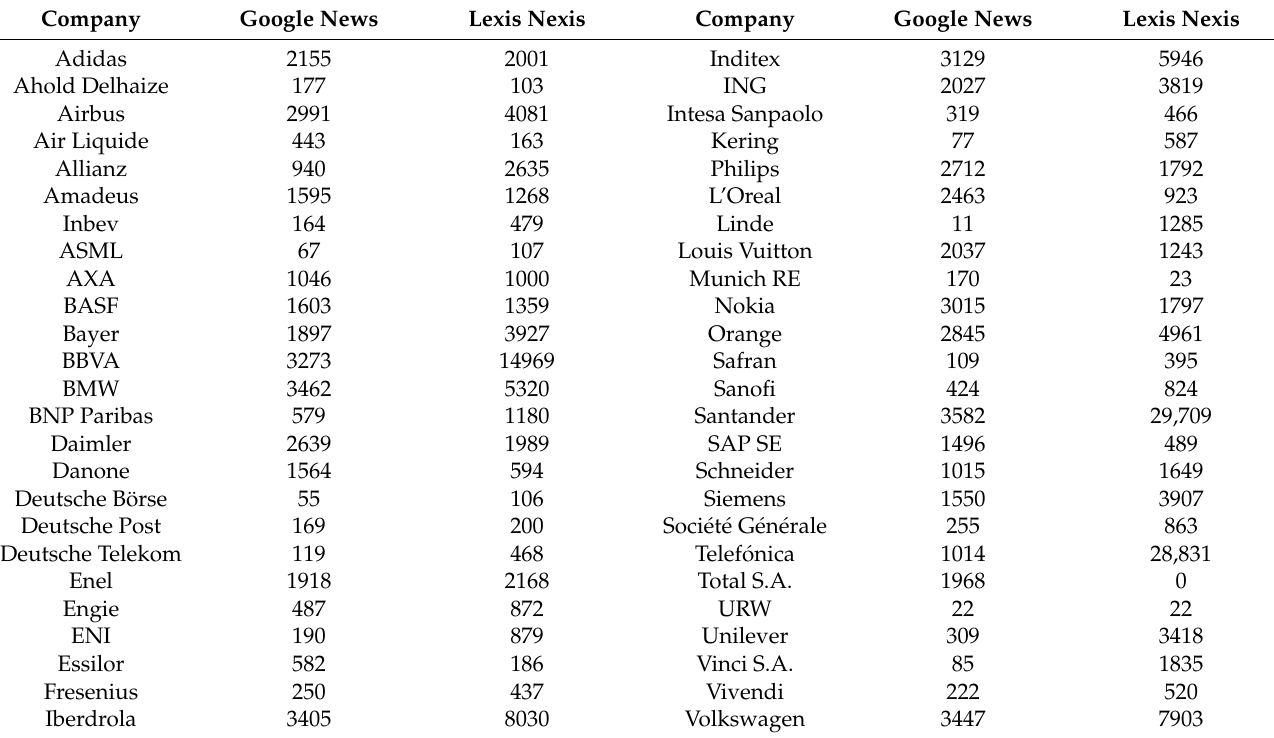
Table 1. Sample of news analyzed by